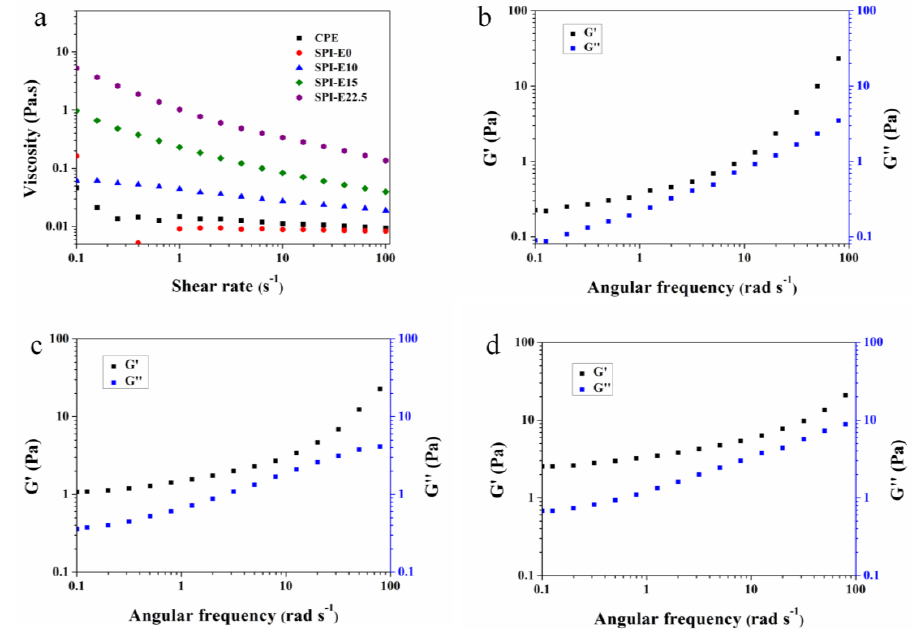
Figure 5. ( a ) Changes in viscosity of blended solution with different CPE content. Dynamic rheological properties obtained at 0.5% strain for blended solution: ( b ) SPI-E12.5; ( c ) SPI-E17.5; and ( d )